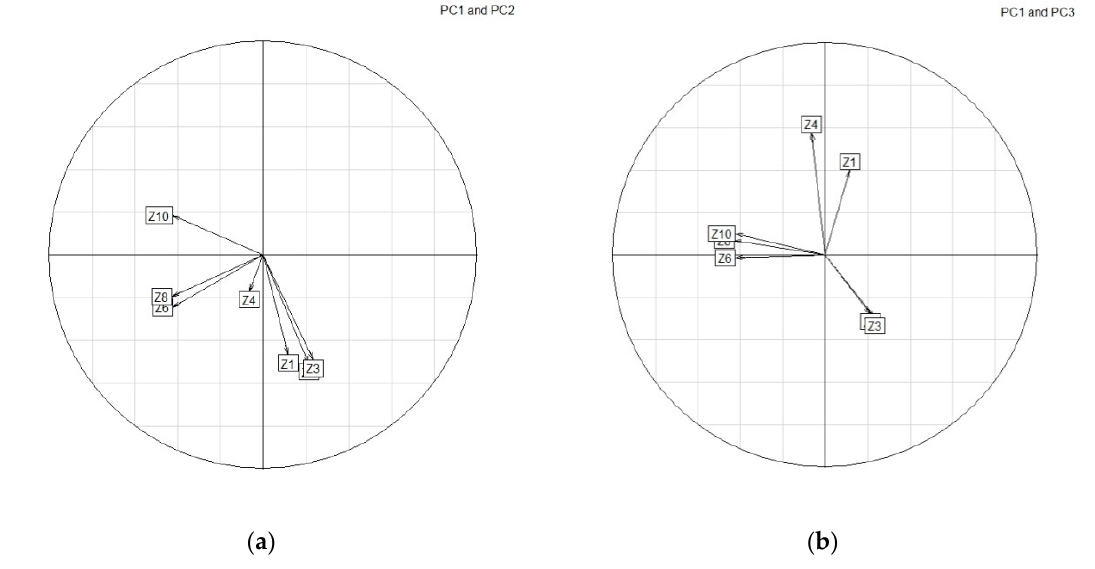
Figure 4. Biplot graphics for removal efficiency (with PC1 as X-axis). ( a ) PC1 vs. PC2. ( b ) PC1 vs. PC3.